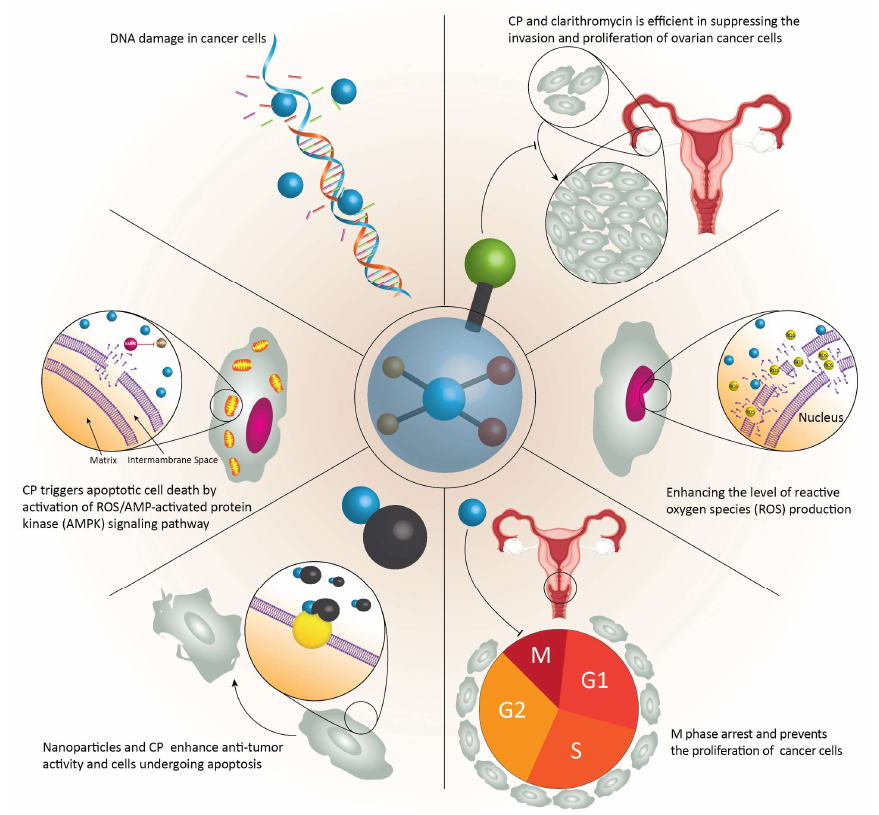
Figure 1. The involvement of di ff erent molecular pathways in anticancer actions of cisplatin